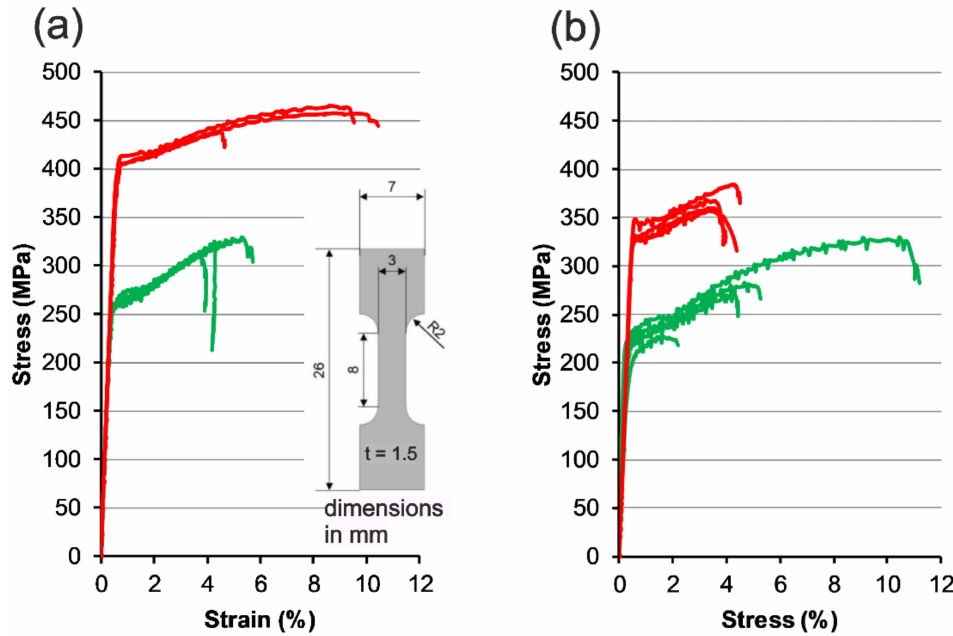
Figure 11. Stress-strain curves of as-built (green) and heat-treated (red) tensile specimens manufactured with the powder variant ( a ) AA7075/TiC/1.75 and ( b )